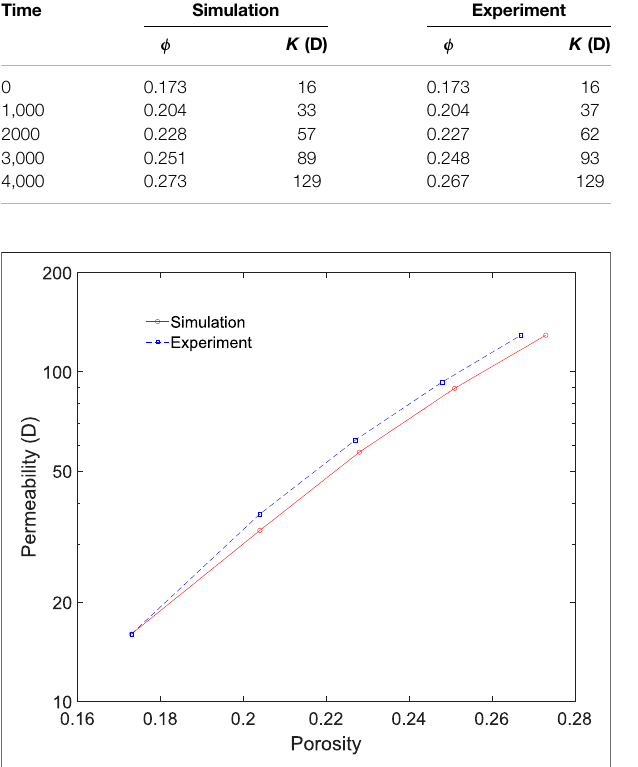
TABLE 7 | Evolution of experimental and simulated reaction rate, reactant concentration and macro-scale reaction constant. The experimental macro- scale constant α * is calculated using the simulated concentration. Time (s)